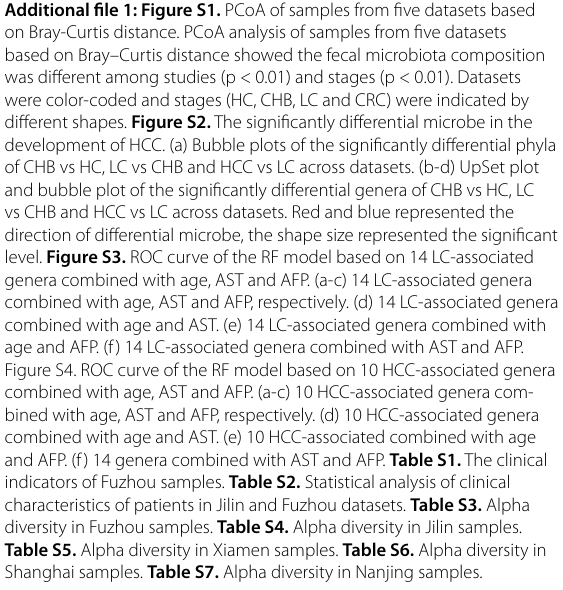
Table S5. Alpha diversity in Xiamen samples. Table S6. Alpha diversity in Shanghai samples. Table S7. Alpha diversity in Nanjing